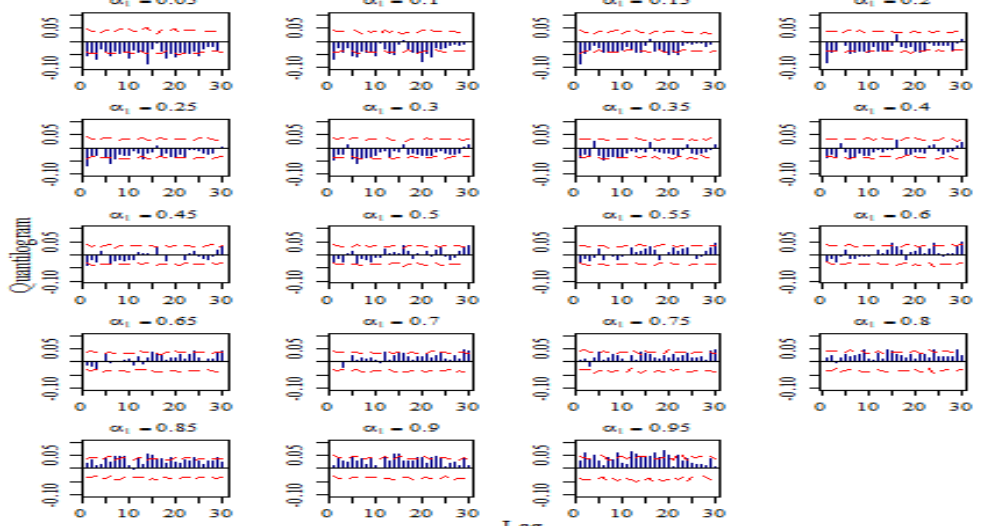
for for 𝑞𝑞 2 ( 𝛼𝛼 2 ) 𝑞𝑞 2 ( 𝛼𝛼 2 )